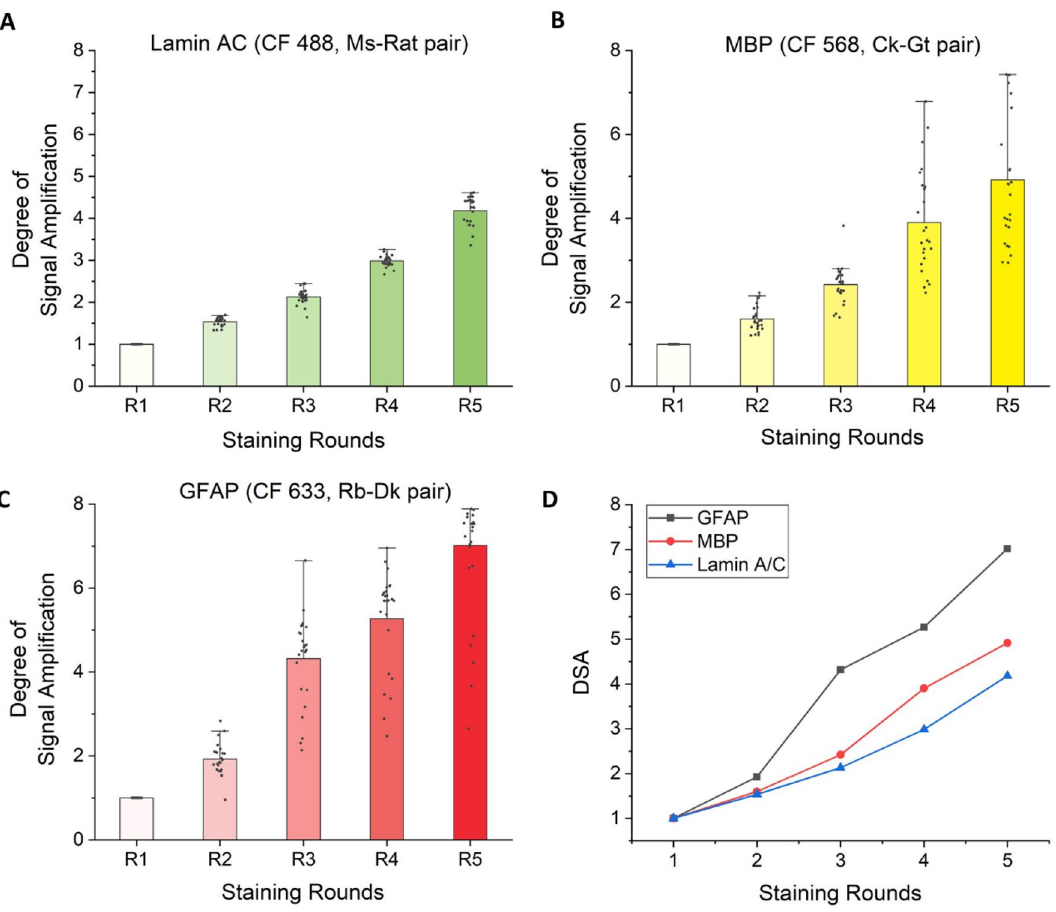
Figure 4. DSA analysis. ( A – D ) Degree of signal amplification of each channel: ( A ) lamin A/C. ( B ) MBP. ( C ) GFAP. ( D ) Average degree of signal amplification (DSA) of each channel. The signal intensity was measure at 25 different points during each staining